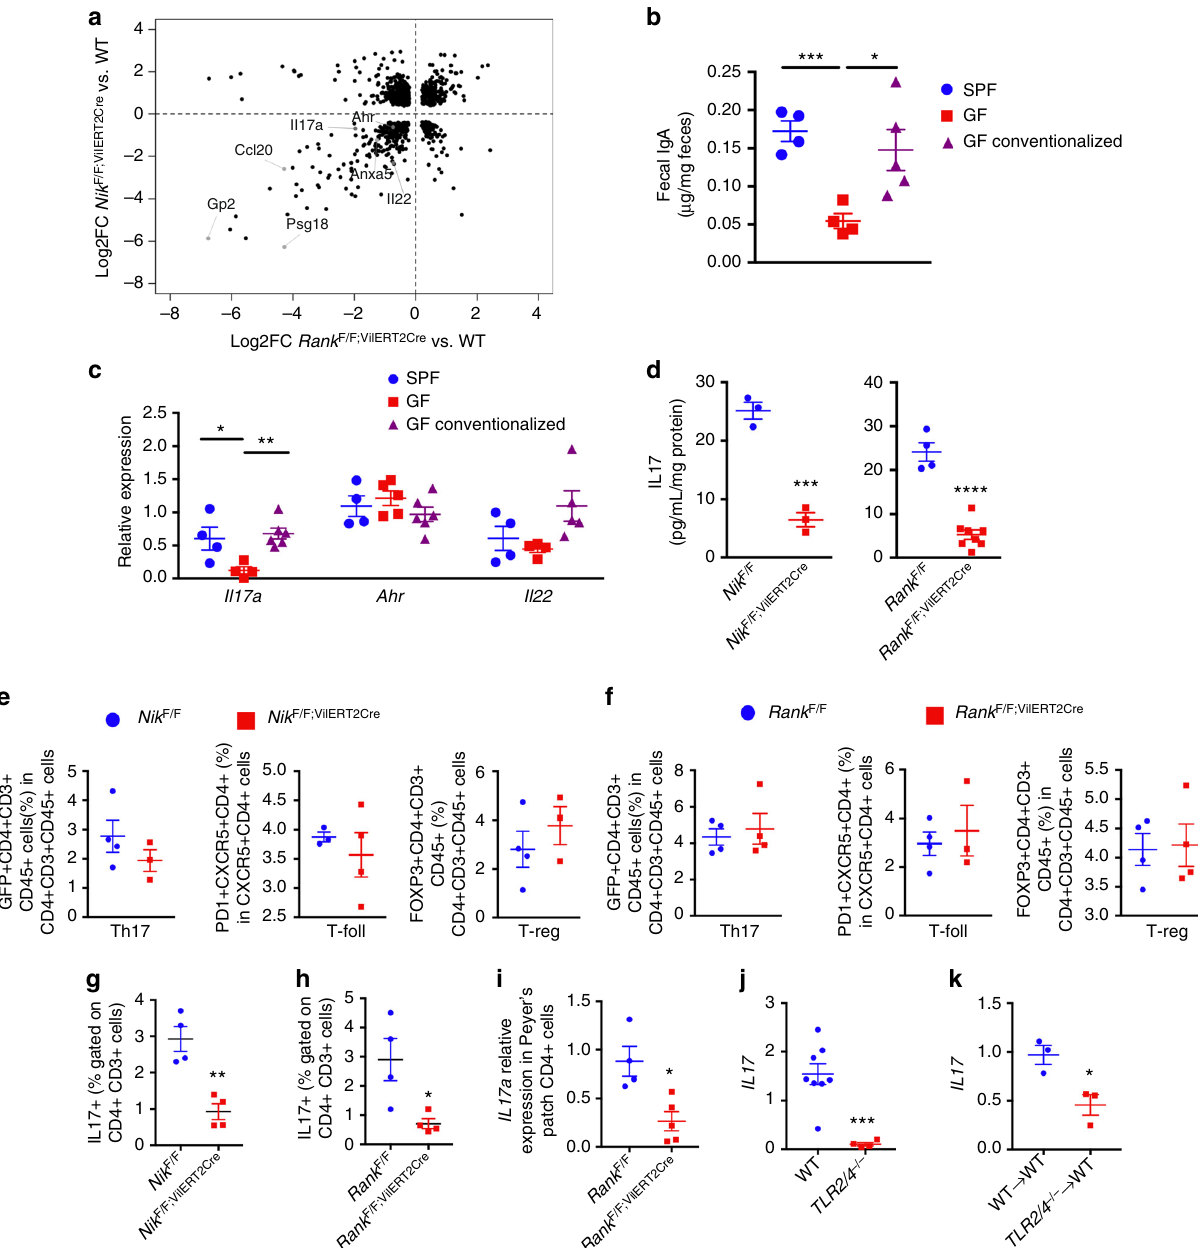
Fig. 4 Epithelial NIK signaling regulate IL17 expression in T-cells. a RNA-seq analysis performed in the Peyer ’ s patches of 7-week-old Nik F/F;VilERT2Cre and Rank F/F;VilERT2Cre mice isolated 2 weeks after tamoxifen treatment. b , c Fecal IgA ( b ) and qPCR analysis ( c ) performed in the Peyer ’ s patches of speci fi c pathogen free (SPF), germ free (GF) and GF mice conventionalized for 2 weeks by fecal transplant from SPF donors. d IL17 ELISA in the colon of Nik F/F; VilERT2Cre and Rank F/F;VilERT2Cre mice that were treated with 2% DSS for 7 days, following 1 week after disruption of NIK or RANK. e , f Flow analysis of T-cells in the PP of Nik F/F;VilERT2Cre ( e ) and Rank F/F;VilERT2Cre mice ( f ). g , h Flow analysis to determine the percentage of IL17 + cells in the PP of Nik F/F; VilERT2Cre ( g ) and Rank F/F;VilERT2Cre mice ( h ). i qPCR analysis of Il17a mRNA levels in the fl ow-sorted CD4 + cells from the Peyer ’ s patches of Rank F/F; VilERT2Cre mice. j qPCR analysis of Il17a mRNA levels in the Peyer ’ s patches of Tlr2/4 − / − mice. k qPCR analysis of Il17a mRNA levels in the Peyer ’ s patches of WT mice assessed 2 weeks after transplant with bone marrow from WT or Tlr2/4 − / − mice. Results are expressed as mean ± SEM. Signi fi cance determined using one-way ANOVA for b , c and t -test for d – i . * P < 0.05; *** P < 0.001; **** P < 0.0001 vs. Jh − / − WT